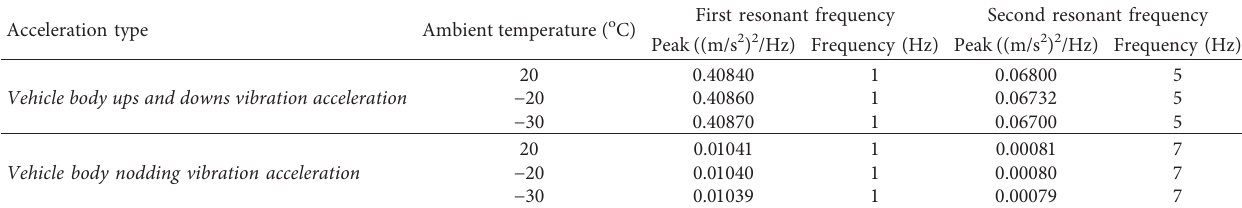
Table 6: Car body acceleration power spectrum peak and peak